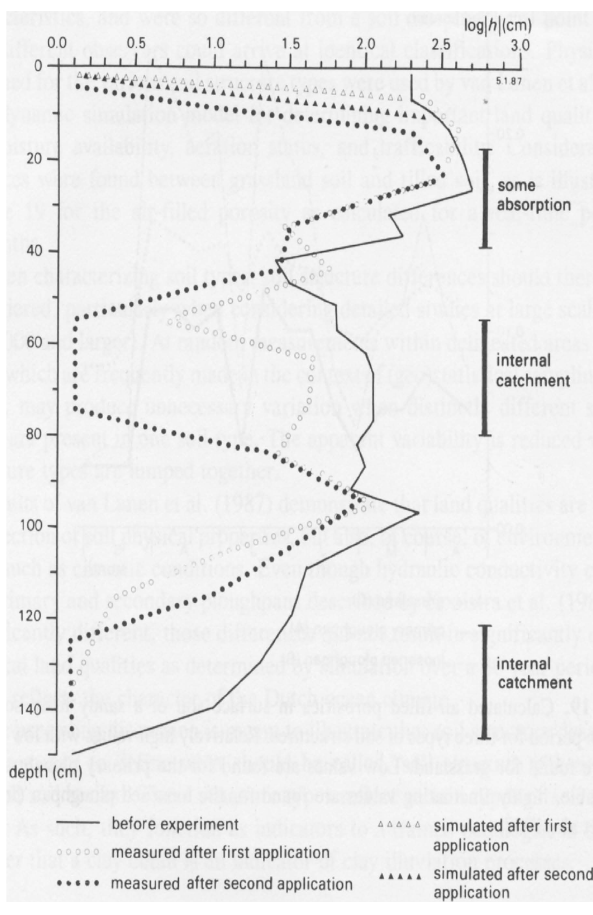
Fig. 3. Field- measured bypass flow and internal catchment in a silt loam soil with vertical macropores, demonstrating rapid wetting at around 60cm and 140cm depth (from van Stiphout et al.,